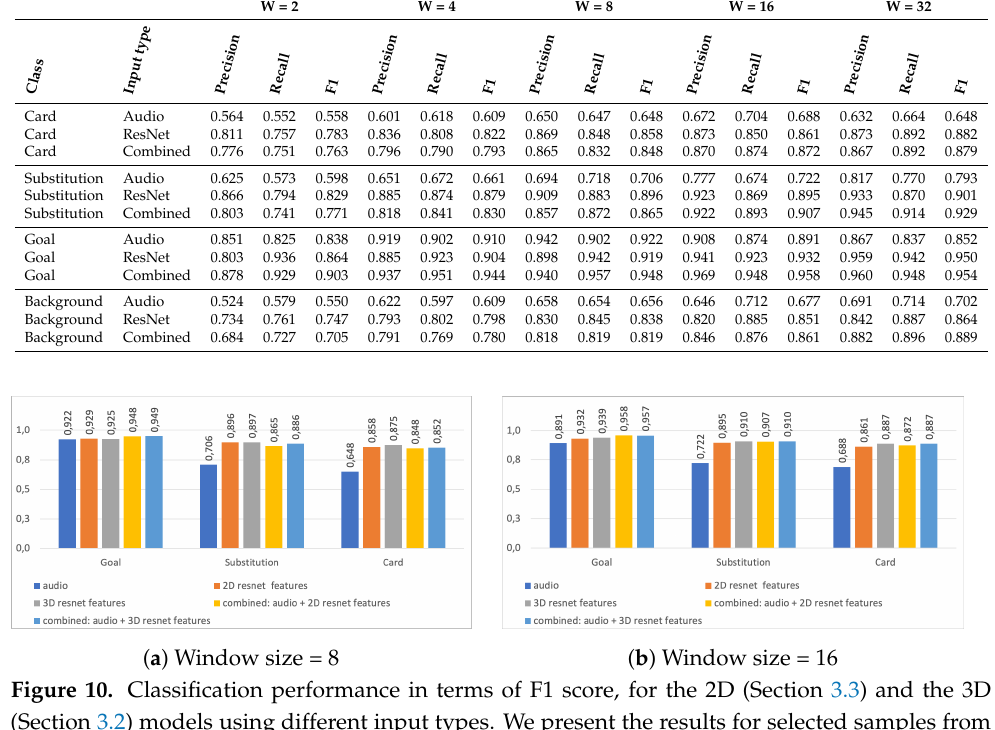
Table 7. Comparison of precision, recall, and F1-score per class (event type), for the 2D model (Section 3.3). W is the window size used for the input. The input type Combined is the combination of the Resnet and audio models. The results for the Combined input type are obtained using late fusion with softmax average.